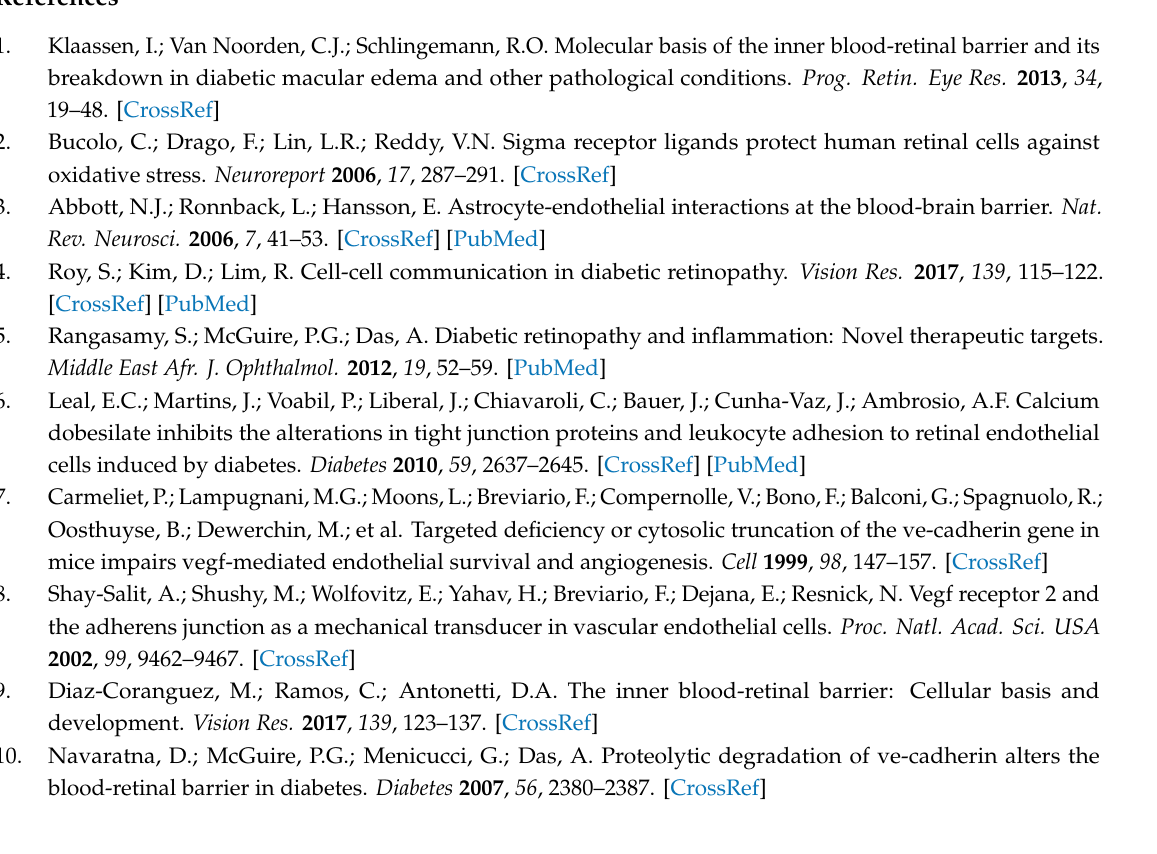
Figure S1: The purity of endothelial cells, pericytes, and astrocytes was confirmed by immunofluorescence staining with (A) von Willebrand factor, (B) α -SMA, and (C) GFAP,